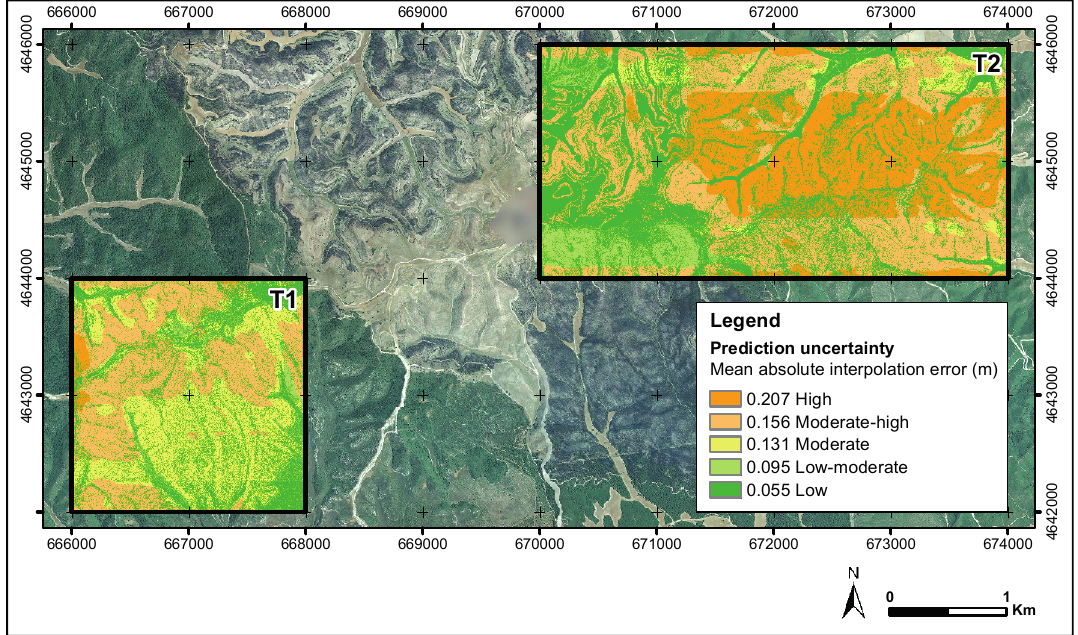
Figure 4. CART-derived prediction uncertainty map over the high spatial resolution orthophotography (PNOA-2009) used as backdrop for 1 m TIN to raster DEM. For this surface, slope, ground return density and land cover were the best predictors of interpolation